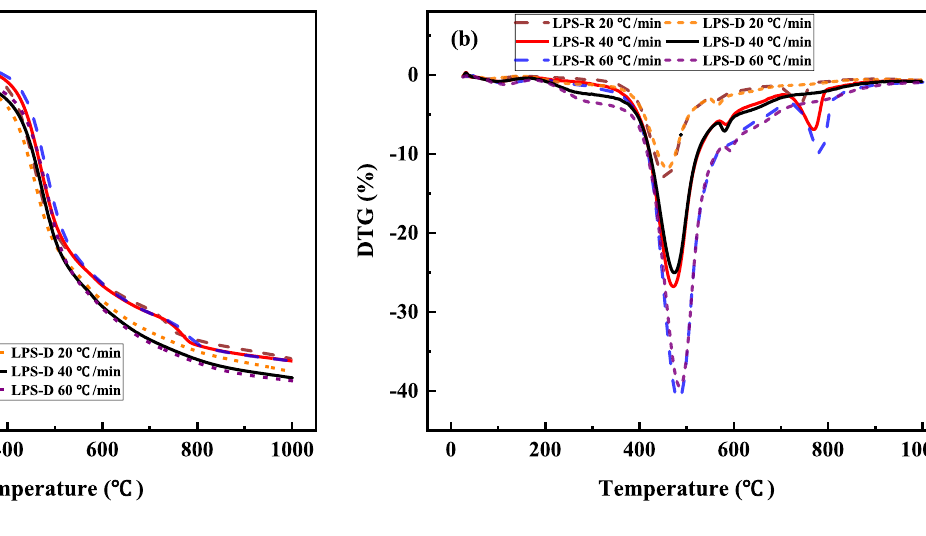
Fig. 4 Pyrolysis characteristic curve of LPS-R and LPS-D